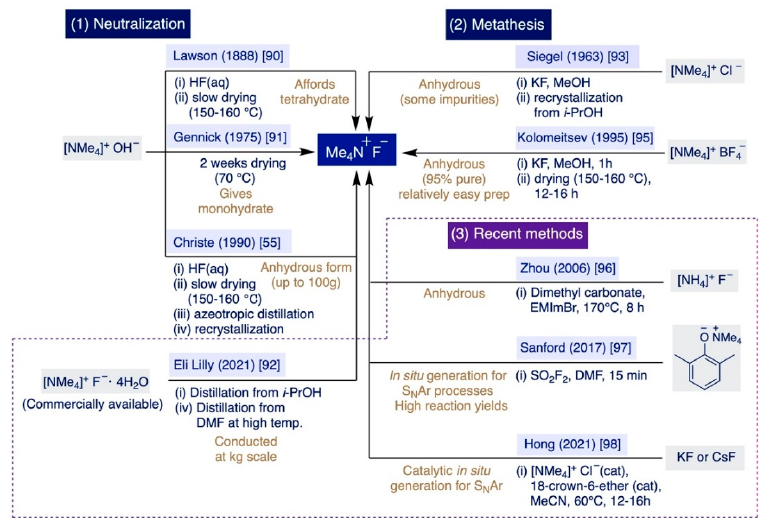
Scheme 5. Preparation of TMAF: (1) Neutralization, (2) Metathesis, and (3) Recent